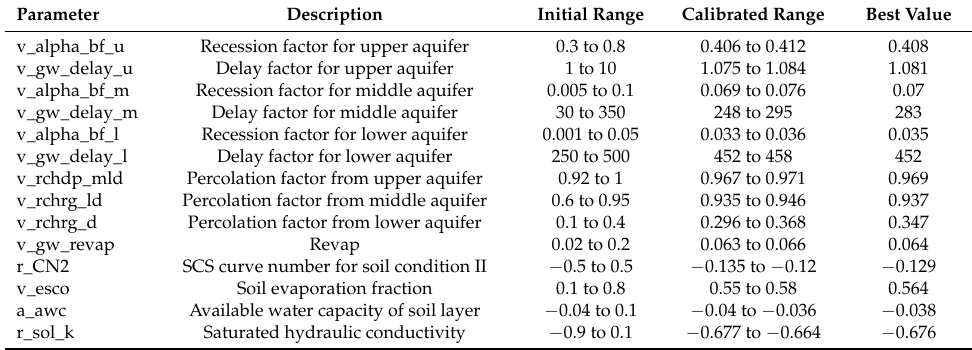
Table 2. The initial and calibrated parameters selected for the SWAT model for the period